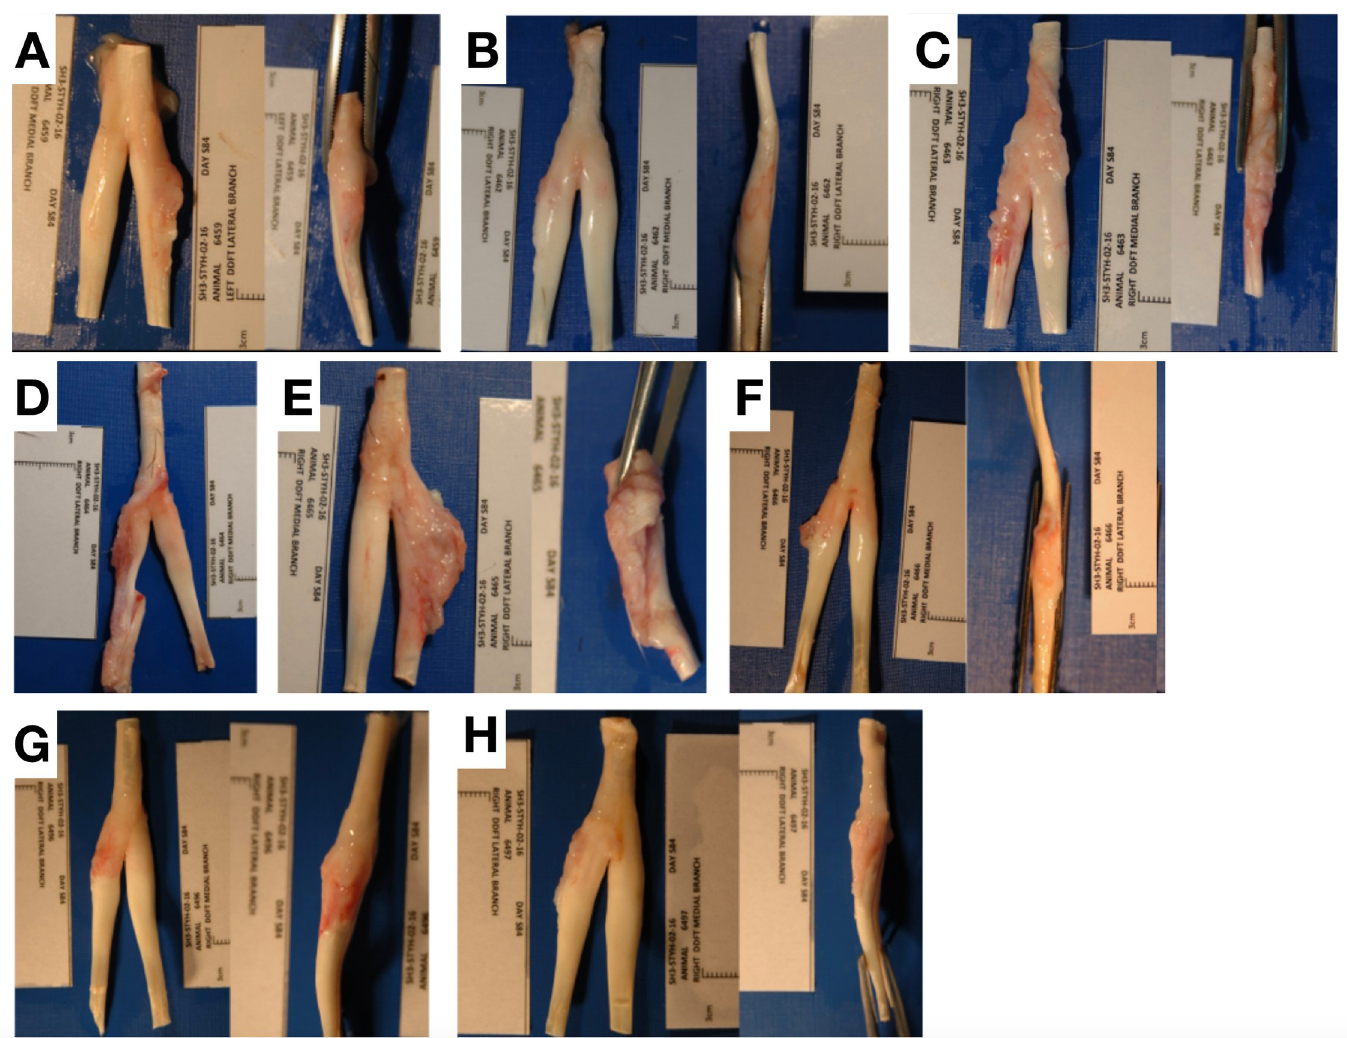
Fig 3. Macroscopic appearance of ES suture implanted ovine tendons. Digital photograph images showing harvested tendons augmented with the ES sutures at 3 months post repair. Sheep 6459, 6462, 6463, 6464, 6465, 6466, 6496, and 6597 are shown in A-H respectively. Proximal is to the top of the image.